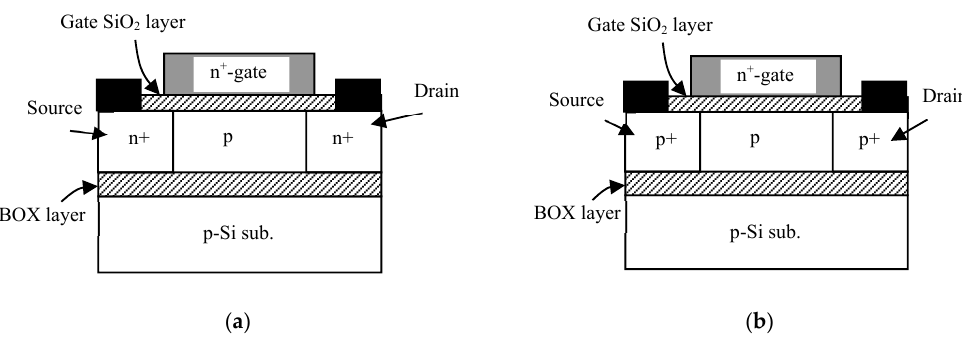
Figure 1. Schematic silicon-on-insulator (SOI) device structures used in experiments. ( a ) n-type inversion-channel (IC) metal-oxide-semiconductor field-effect transistors (MOSFET), ( b ) p-type buried-channel (BC) MOSFET. Table 1. Parameters of fabricated devices.